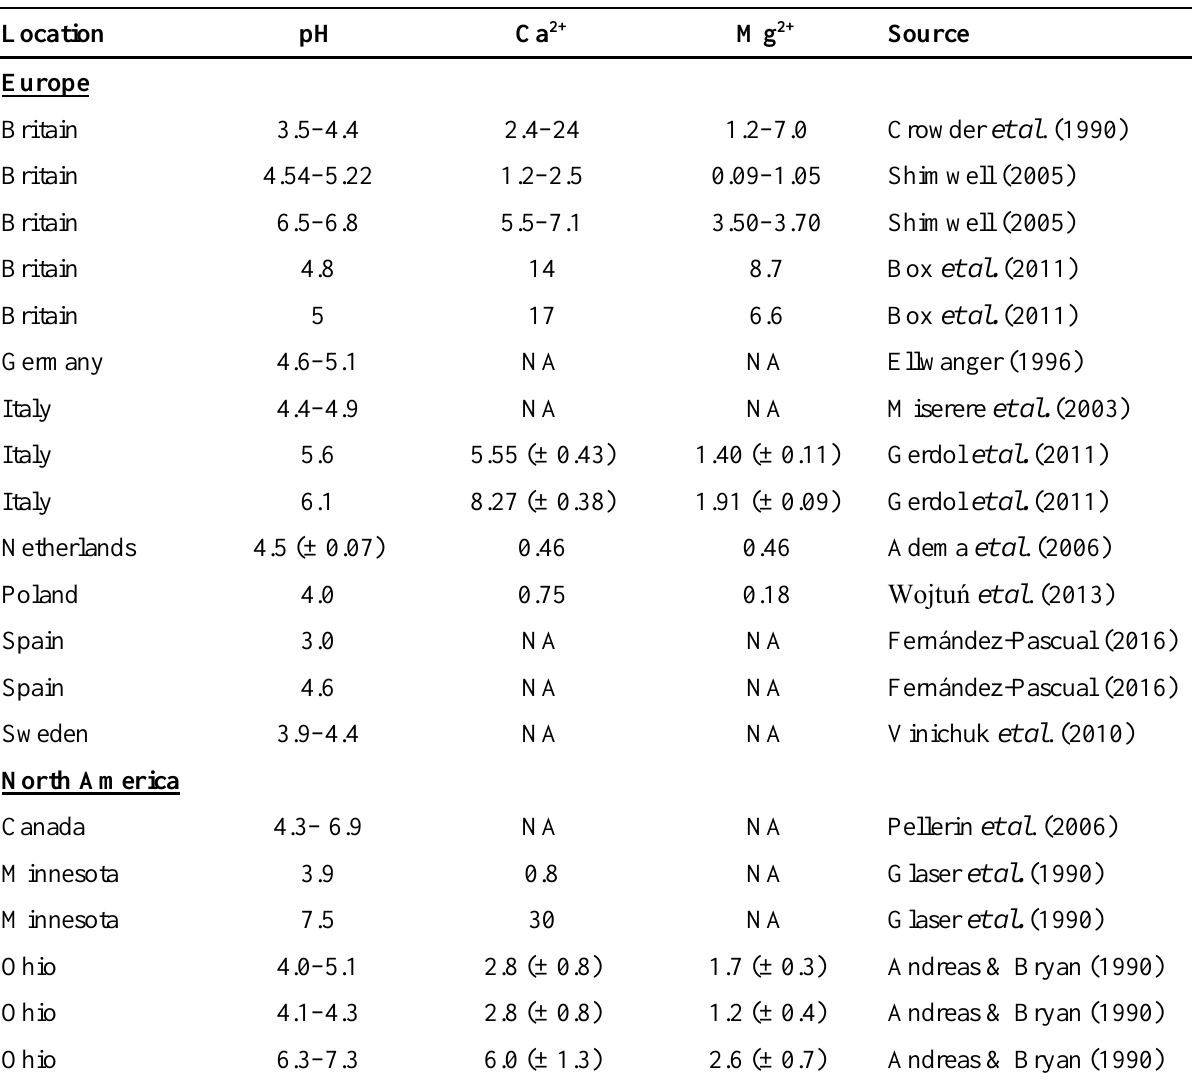
Table 2. pH, calcium (Ca 2+ ) and magnesium (Mg 2+ ) concentrations (mg L -1 ) in water of wetlands with Drosera rotundifolia . (Some publications list more than one site, e.g. Fernández-Pascual (2016): Los Cándanos pH 3.0 and La Veiga Cimera pH 4.6) . NA = not